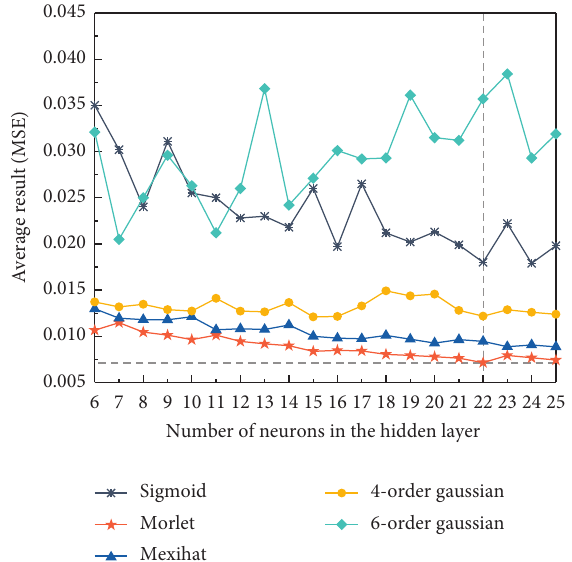
Figure 2: Average MSE of 50 runs using WNN with different architectures.